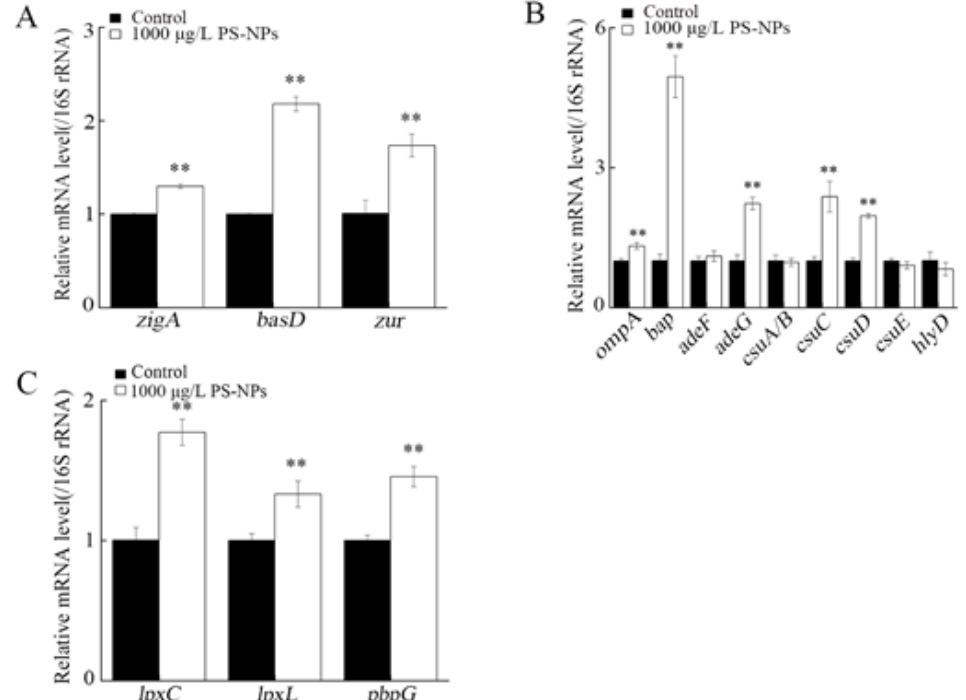
Figure 7. Effect of nanopolystyrene particle (NP) exposure on expression of virulence genes in A. johnsonii AC15. ( A ) Survival related genes. ( B ) Biofilm formation related genes. ( C ) Serum resistance related genes. ** p < 0.01 vs. Control.